Question: Write a single sentence explaining what this figure depicts.
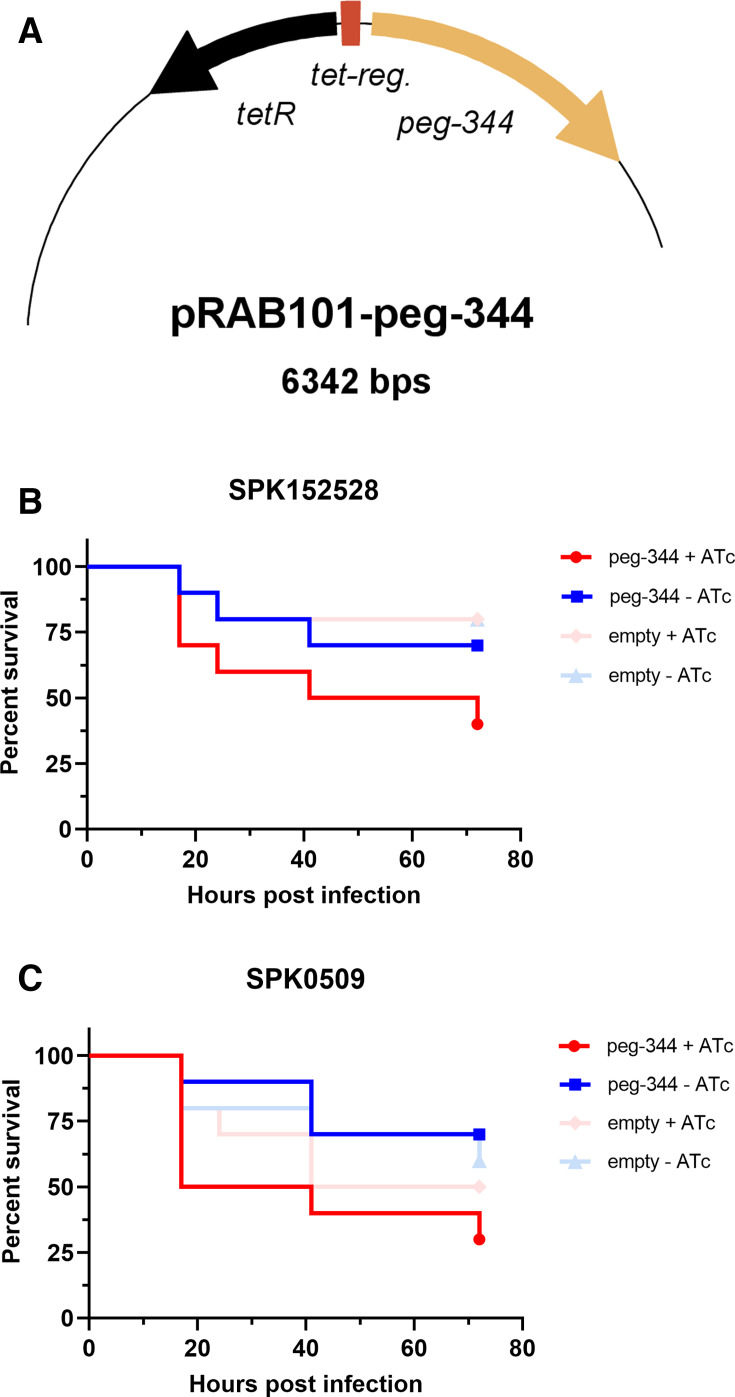
Answer: ( A ) Partial map with features of plasmid pRAB101-peg-344. Other features identical to those of pRAB101-sfgfp were omitted. ( B ) Pathogenicity of strains SPK152538 (natively peg-344 -negative) carrying pRAB101-peg-344 or pRAB101e and cultivated with or without ATc in G. mellonella larvae. Survival curves were analyzed using the Kaplan-Meier method (log-rank test). Results obtained with strains carrying pRAB101e (“empty”) are given in faint colors. ( C ) Analogous experiments with SPK0509 (natively peg-344 -positive) carrying each of the two different plasmids.